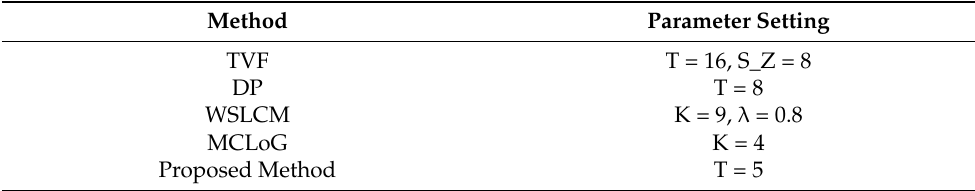
Table 3. Partially set parameters for SOTA methods.